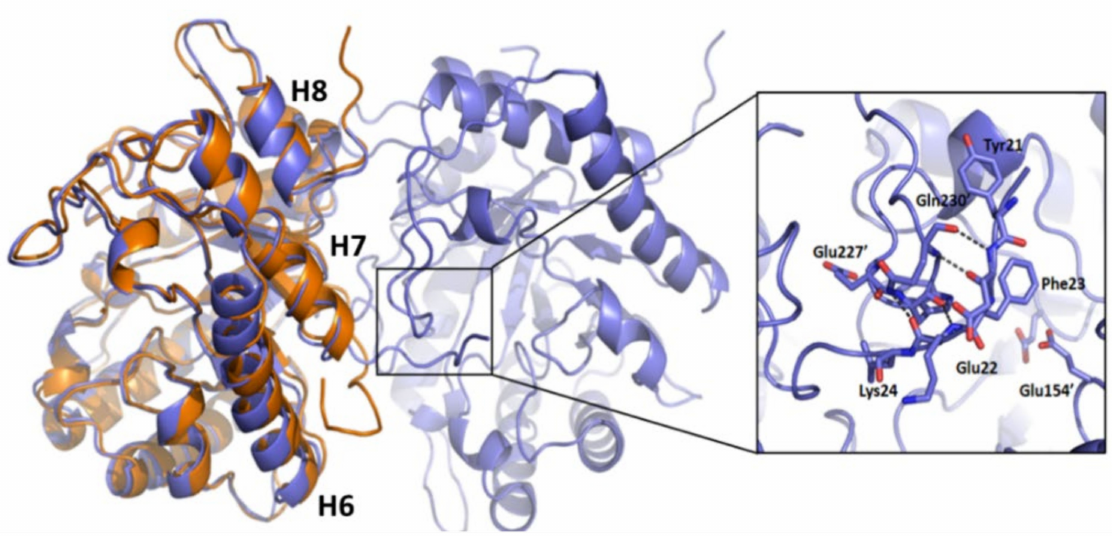
Figure 4. Cartoon representation of the superposition of DtCel5A obtained in P3 2 (blue) and P2 1 2 1 2 1 (orange) space groups. The inset shows the interactions between the N-terminal fragment of one molecule with loop 227–230 of the adjacent molecule in the P3 2 space